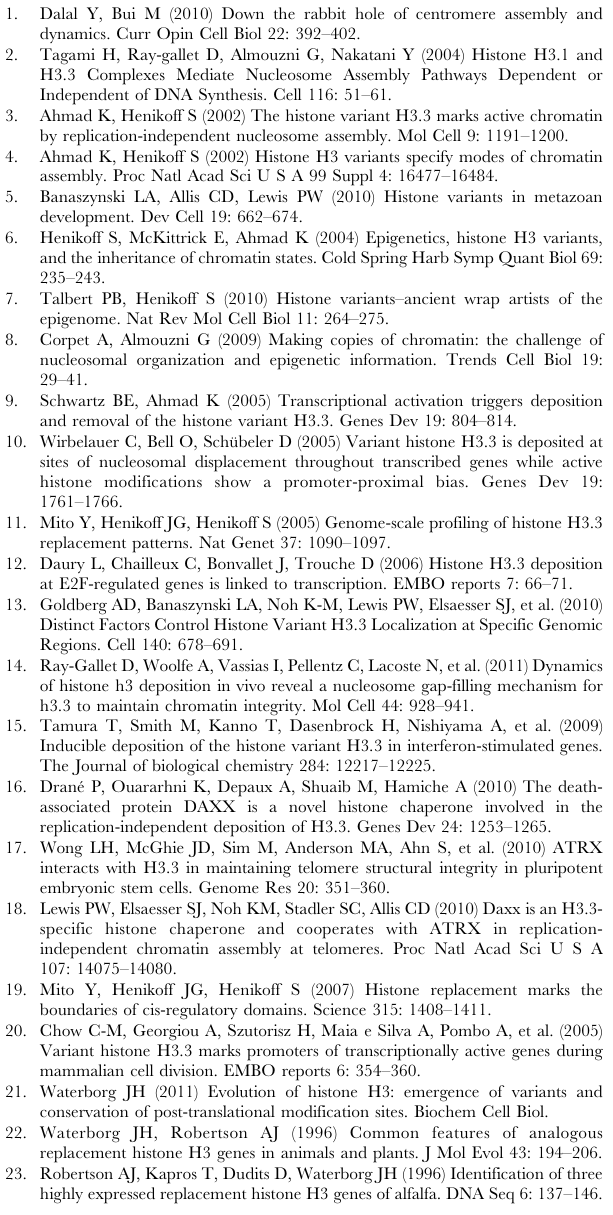
Table S4 Tab-delimited file containing the average signal of all datasets used in the boxplots and scatterplots over each annotation (total and last kb), inter-annotation and CS segment.